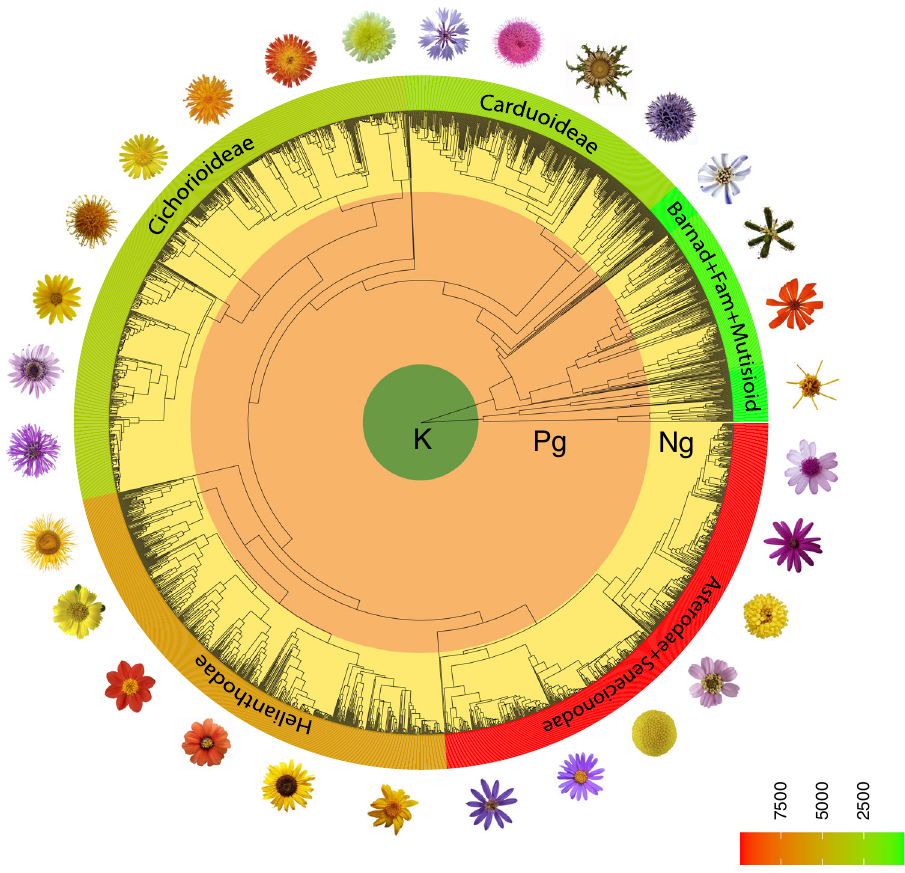
Fig. 1 Phylogenetic tree scaled to geological time of Asteraceae with 2723 sampled tips. Asteraceae is one of the most species-rich families of fl owering plants with more than 23,000 species. The number of non-sampled (missing) species increases enormously towards the more derived and species-rich lineages. For this reason, the sampling among clades is severely biased. Note that these rich and derived lineages evolved during the late Paleogene or early Neogene. K Cretaceous, Pg Paleogene, Ng